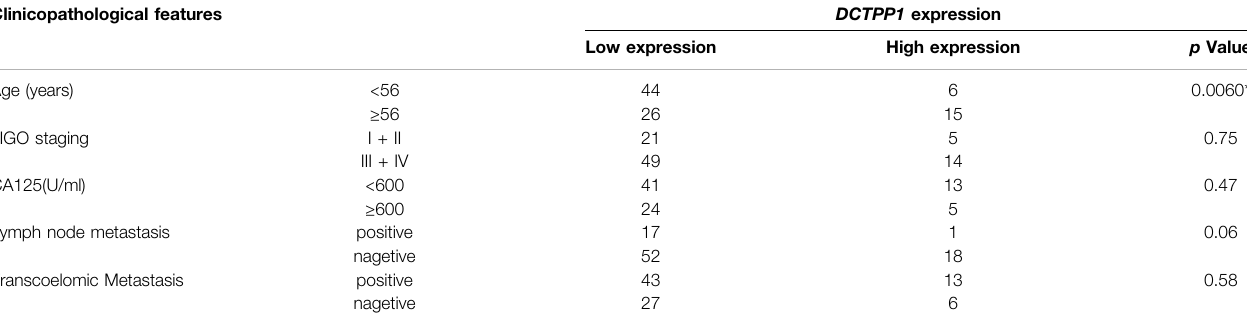
TABLE1 | Correlation between DCTPP1 expression and clinicopathological